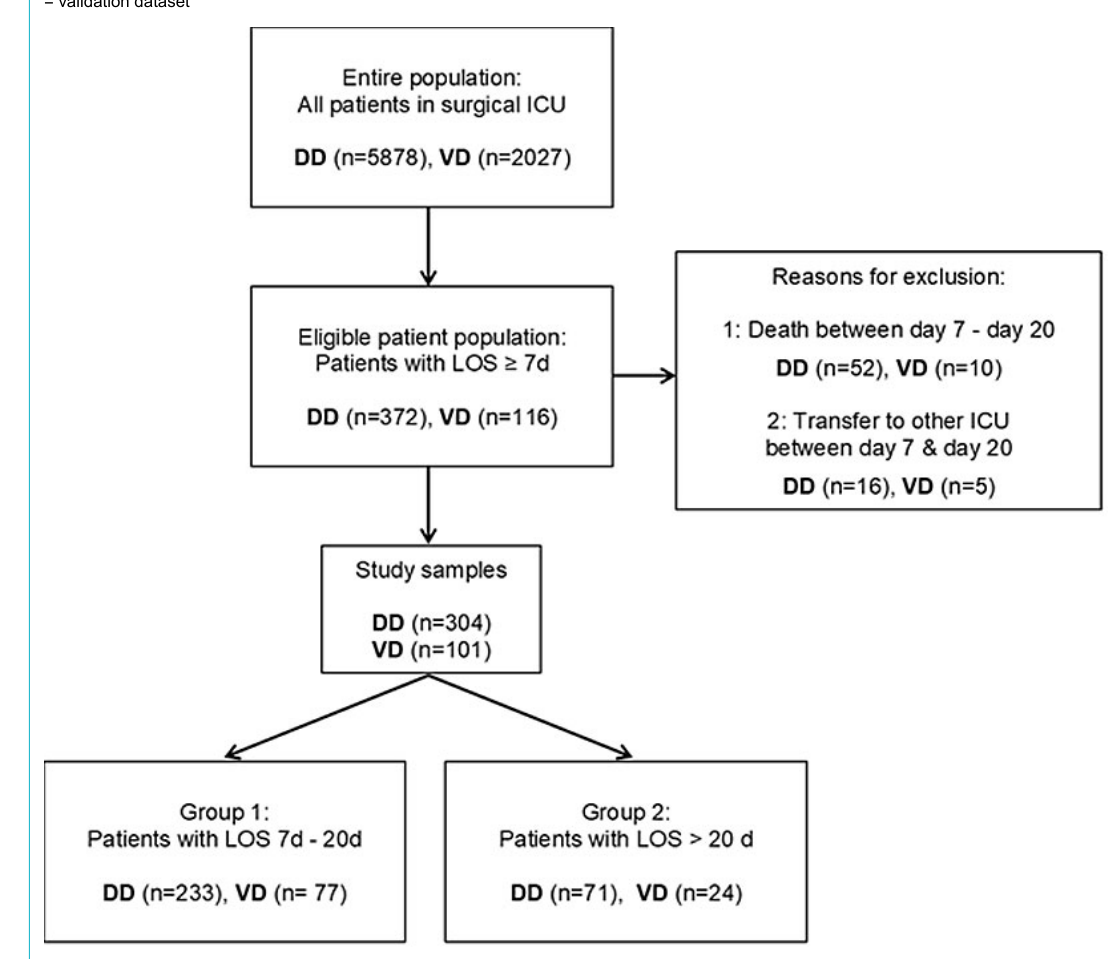
Figure 1: Populations, exclusion, study samples and groups. DD = development dataset; ICU = intensive care unit; LOS = length of stay; VD = validation